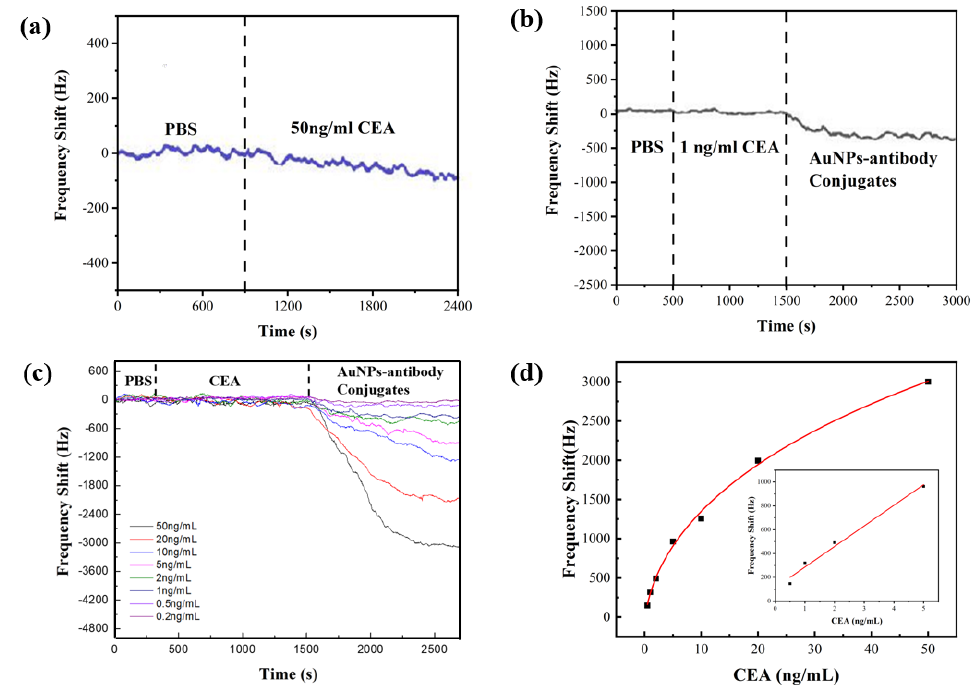
Figure 5. ( a ) Real-time responses of Love mode sensor to 50 ng/mL CEA in the immunoassay with − out AuNPs. ( b ) Real-time responses of the sensor to 1 ng/mL CEA in the AuNP simplified sand − wich immunoassay. ( c ) Real-time responses of sensor to CEA with the concentration varying from 0.2 ng/mL to 50 ng/mL. ( d ) Measured frequency shifts as a function of CEA